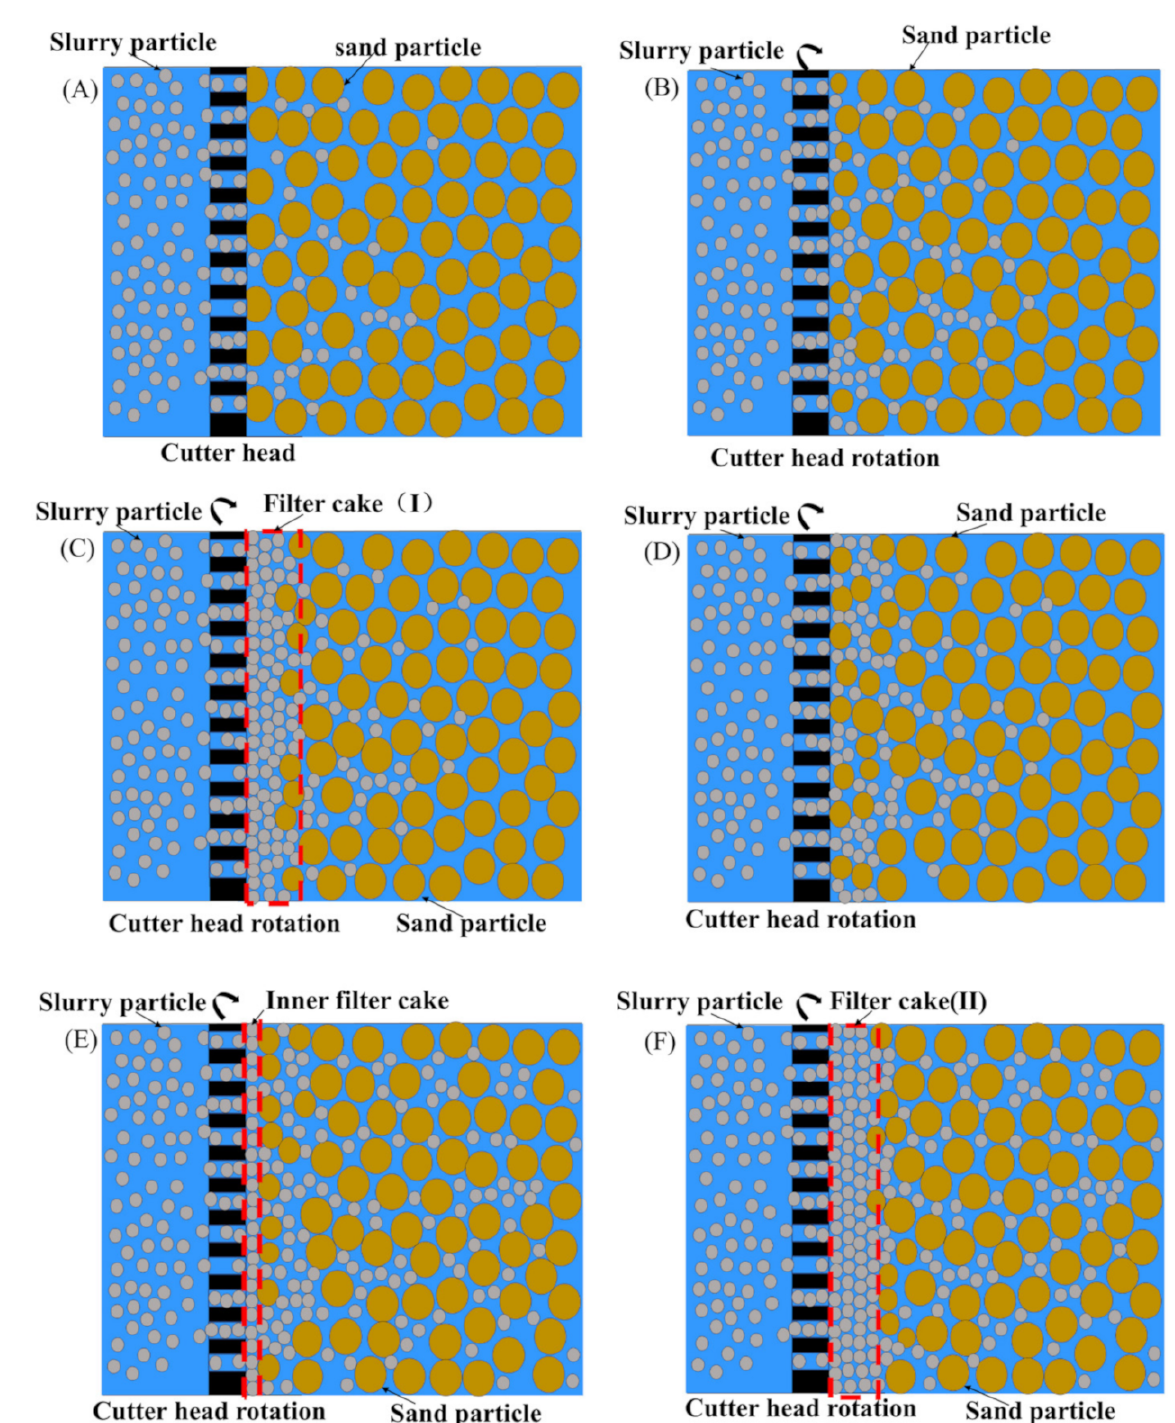
Figure 16. Stages of filter cake formation: ( A ) initial slurry permeation, ( B ) large scale slurry per- meation, ( C ) initial filter cake formation, ( D ) the failure of filter cake, ( E ) deep permeation of slurry, ( F ) final filter cake